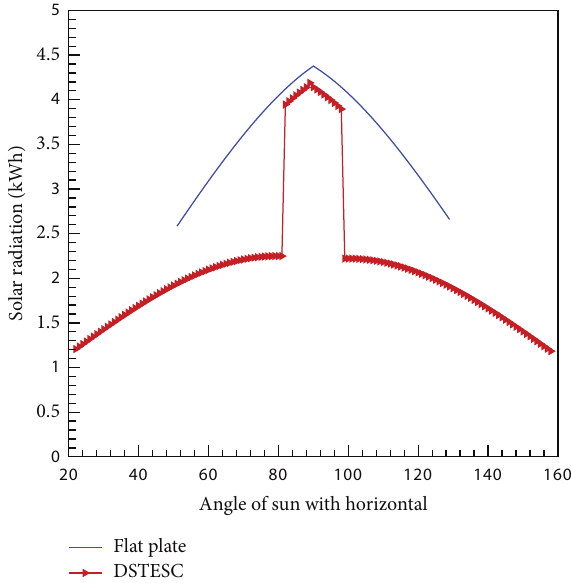
Figure 6: Comparison of radiation capture for flat and new concept.